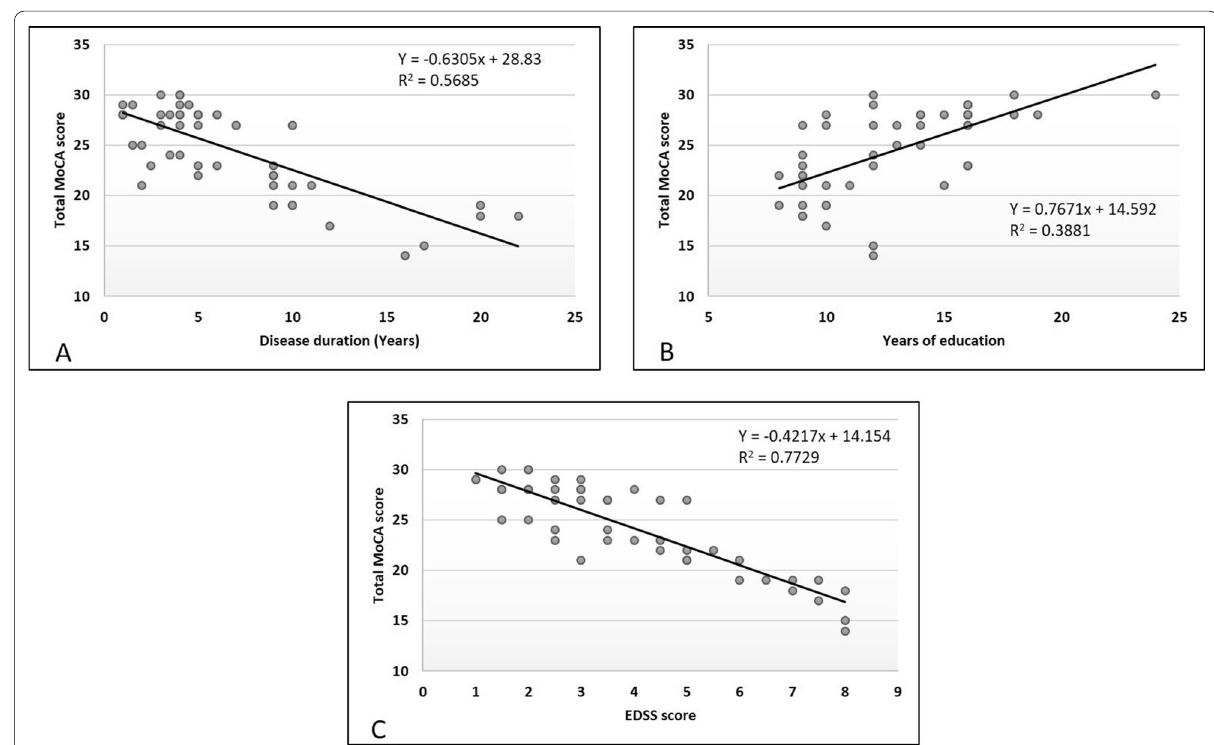
Fig. 1 Correlation of total MoCA and disease duration ( A ) years of education ( B ) and EDSS ( C ) in patients with multiple